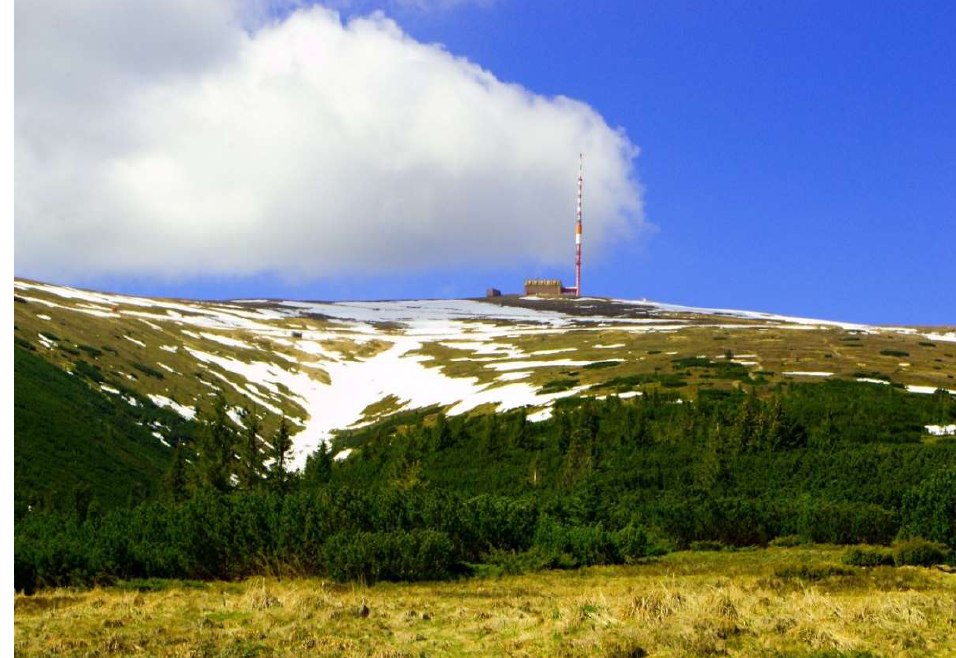
Figure 11. Identification of a trigger zone located in the Hnilec river spring area on the NE slope of Kráľova hoľa hill (1946 m a.s.l.).